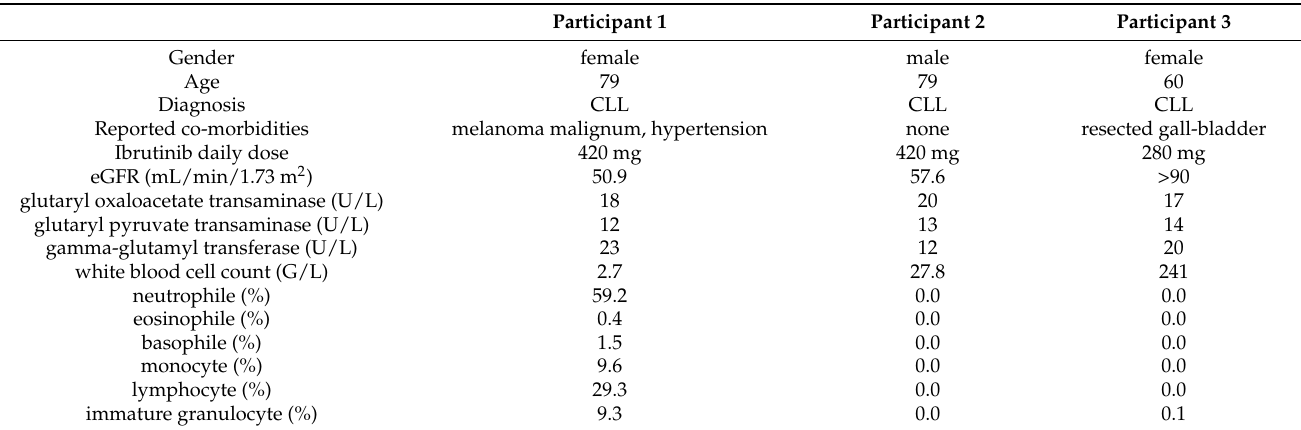
Table 1. Demographic and clinical characteristics of the patients receiving IBR. CLL, chronic lympho- cytic